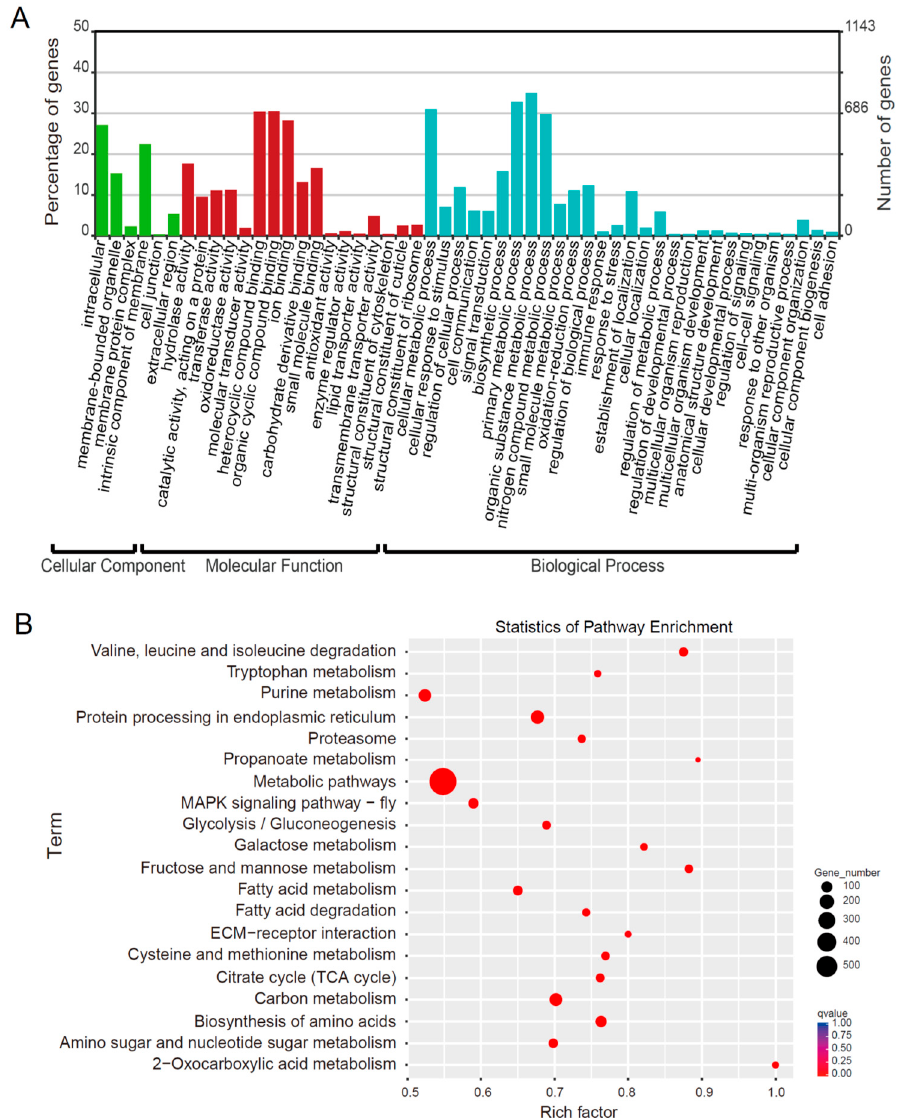
Figure 3. Gene ontology (GO) and Kyoto Encyclopedia of Genes and Genomes (KEGG) pathway enrichment analyses of the differentially expressed genes (DEGs) in the fat body at different stages during silkworm metamorphosis. ( A ) GO annotation of all DEGs. Green, Cell Component; Red, Molecular Function; Blue, Biological Process. ( B ) Scatter plot of the enriched KEGG pathways for all DEGs. Size of dots, Number of enriched genes; Color of dots, the red dots indicated pathways with significant enrichment and the blue dots indicated pathways with low enrichment; Rich factor = the DEGs number/ the number of genes in this pathway; MAPK: mitogen-activated protein kinase; ECM: extracellular matrix; TCA: tricarboxylic acid.